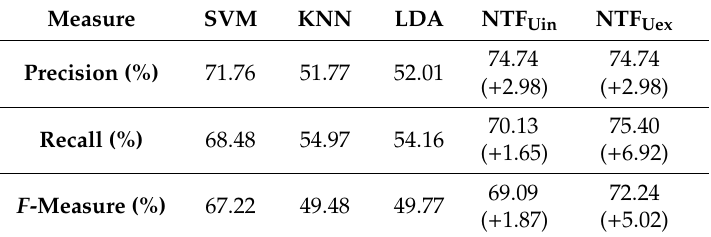
Table 3. Classification measures of the validation dataset with the use of analysed methods. Brackets indicate the NTF accuracy gain in comparison to the best SVM